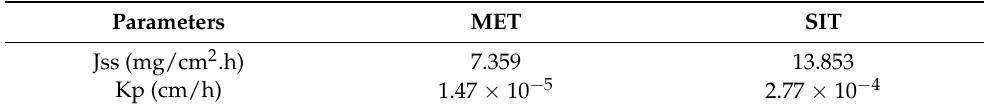
Table 3. Ex vivo permeability of the optimized formulation